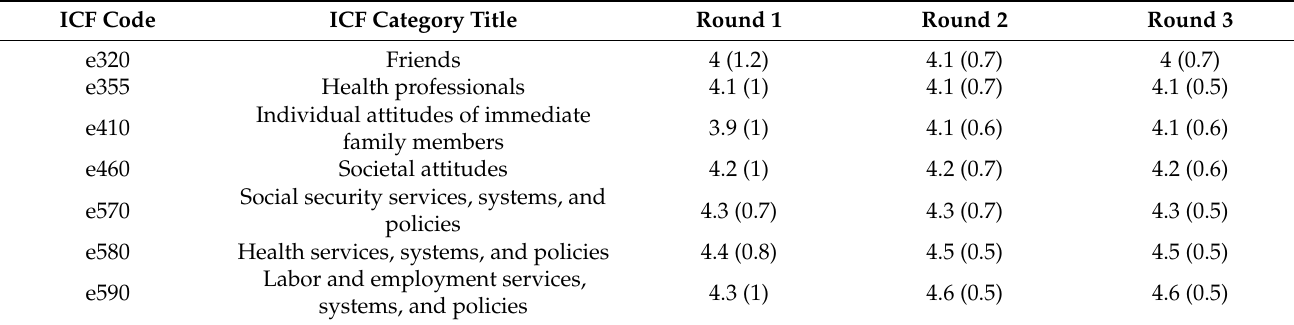
Table 3. International Classification of Functioning, Disability, and Health categories of the environmental factors component rated as important for the assessment of chronic burn injury over the three rounds of Delphi